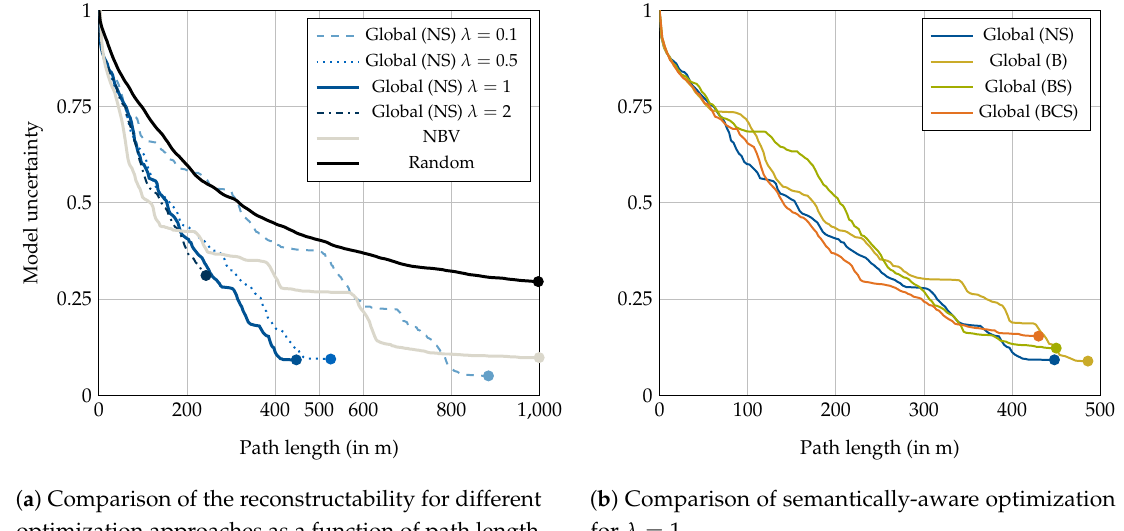
Figure 7. Comparison of different optimization methods in terms of the expected model uncertainty for different path lengths assuming the same objective function. The effects of various regularization parameters are shown in blue and the performances of baseline approaches are depicted in gray and black ( a ). Note that λ = 1 leads to a balanced trade-off between short path lengths and high model certainty. Comparison of the sematically-aware global optimization with λ = 1 for different restrictions on the airspace ( b